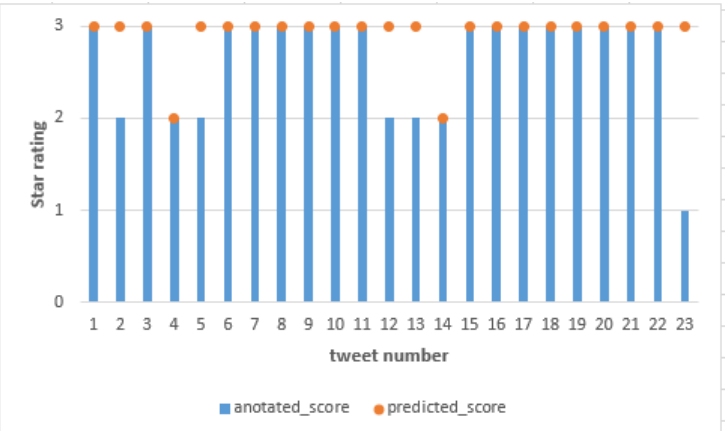
Figure 8. BERT score prediction results for a 3-class